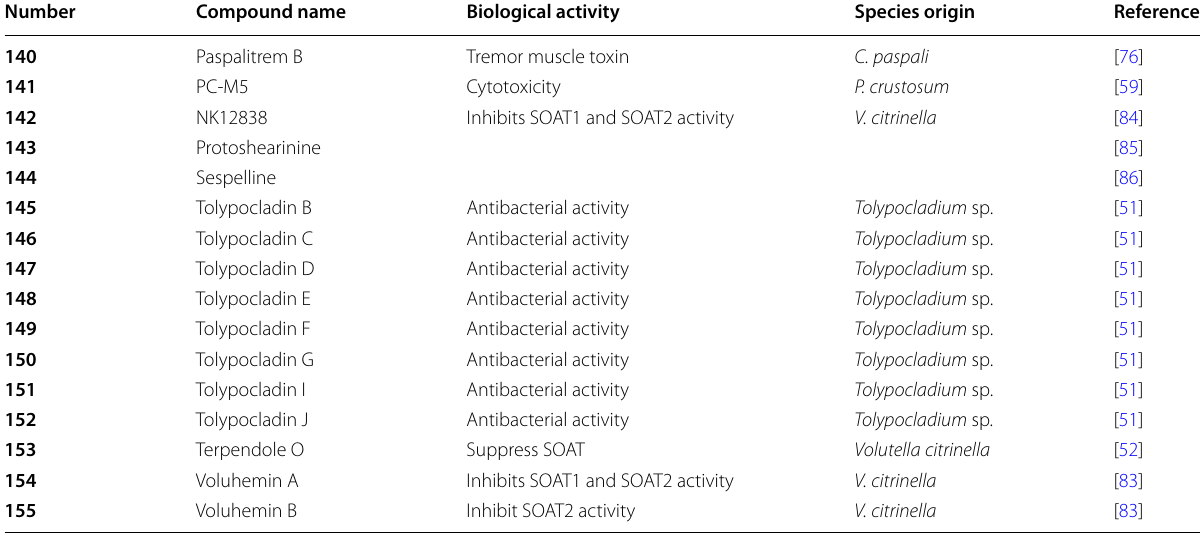
Table 10 Name, bioactivities and source of compounds with the isopentenyl group on the A‑ring is